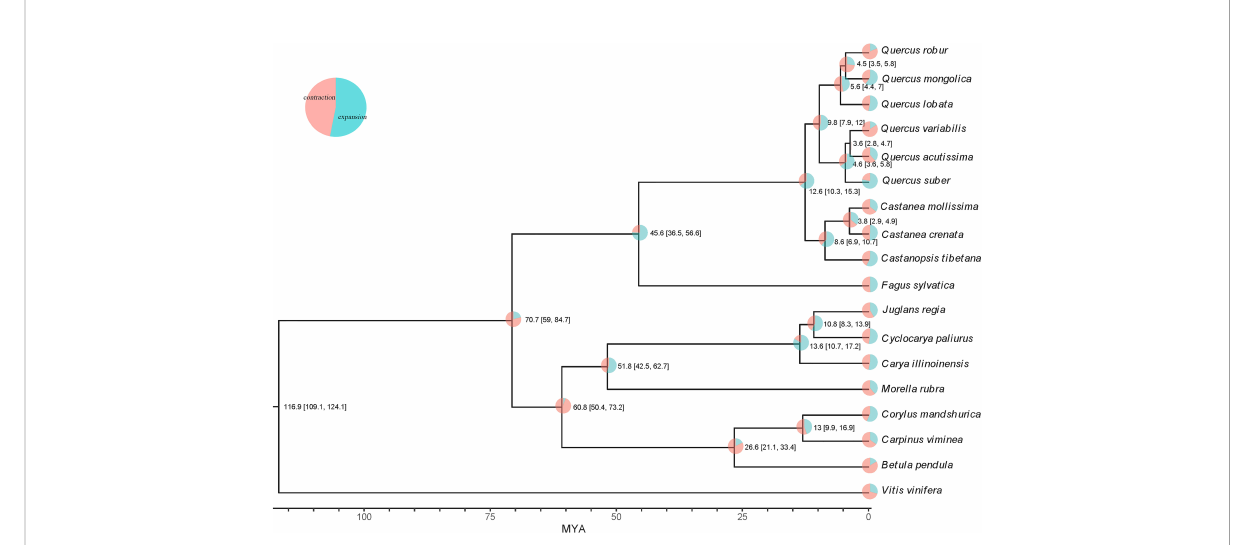
FIGURE 2 Maximum likelihood phylogenetic tree and expanded and contracted gene families in Q. acutissima . The numbers at the branch node in the tree indicate the divergence time and 95% con fi dence